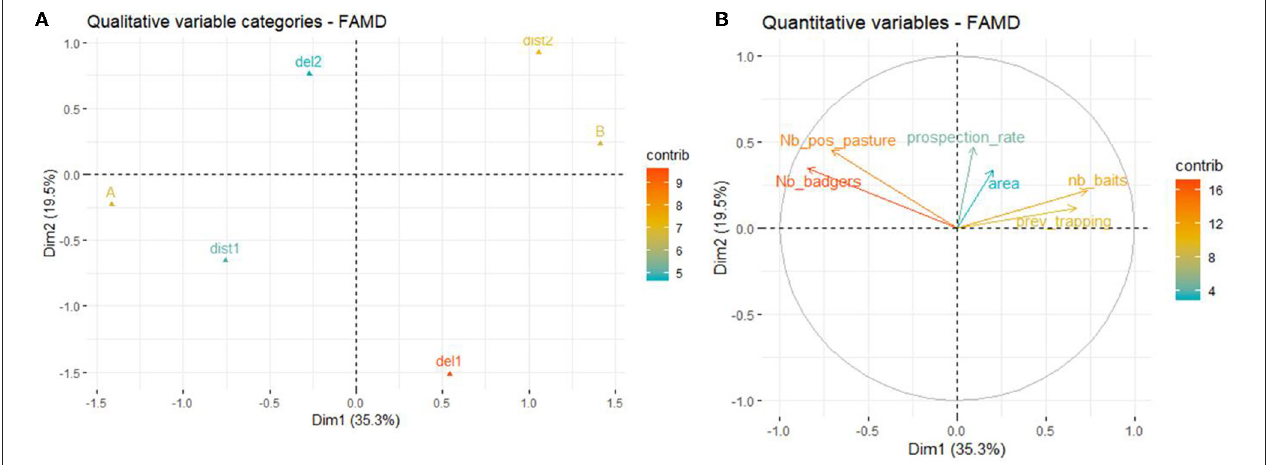
FIGURE 6 | Results of the FAMD at the pasture level. (A) Graph of the qualitative variables plotted on dimensions 1 and 2. (B) Graph of the quantitative variables plotted on dimensions 1 and